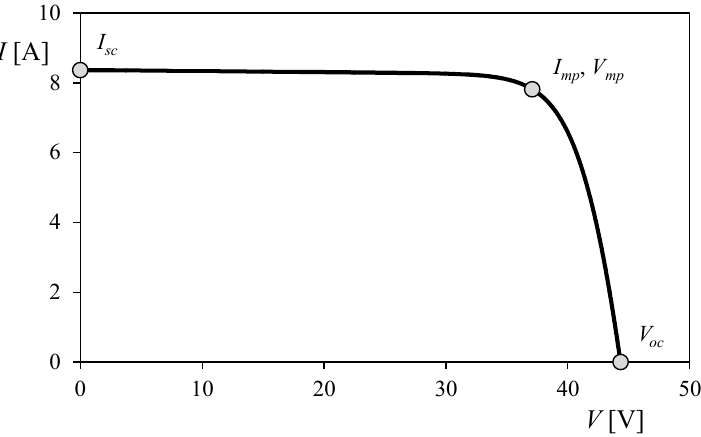
Figure 2. I-V curve of a solar panel. The three characteristic points (short circuit, maximum power, and open circuit points) are indicated on the